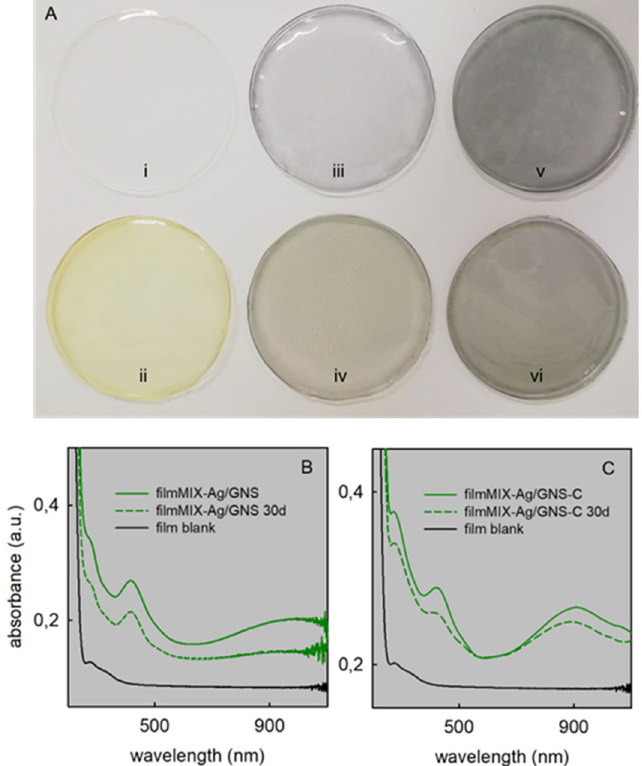
Figure 3. ( A ) Photographs of films (diameter of each disc ~9 cm): (i) film-blank , (ii) film-Ag , (iii) film-GNS , (iv) filmMIX-Ag/GNS , (v) film-GNS-C , and (vi) filmMIX-Ag/GNS-C . ( B ) Absorption spectrum of freshly prepared (green solid line) and 30-days (green dashed line) aged filmMIX- Ag/GNS and ( C ) for filmMIX-Ag/GNS-C . The absorption spectrum of film-blank (black solid line) is added in ( B , C ) for comparison.